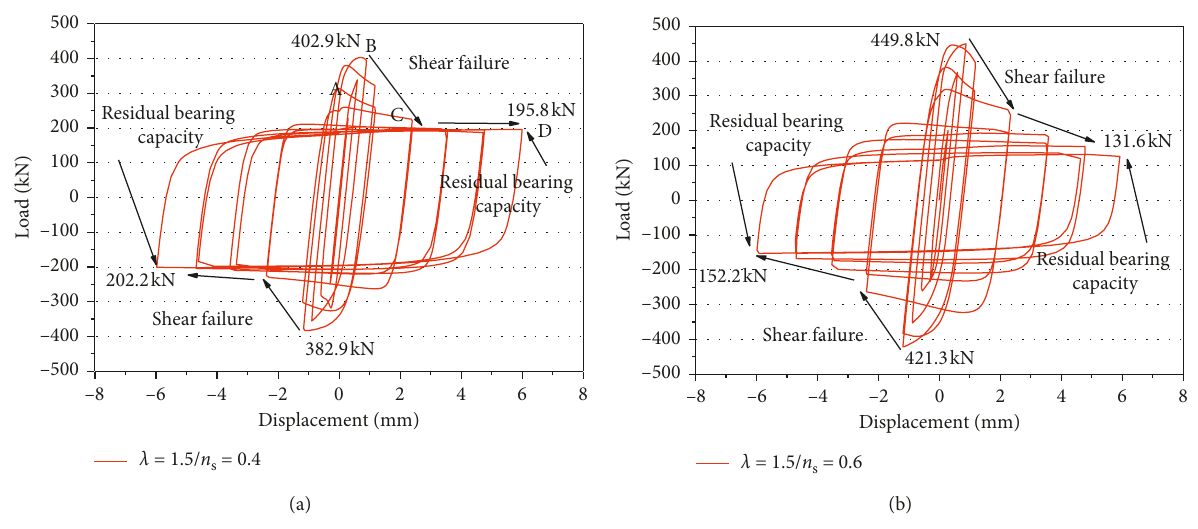
Figure 19: Hysteretic curves of the RC columns. (a) n